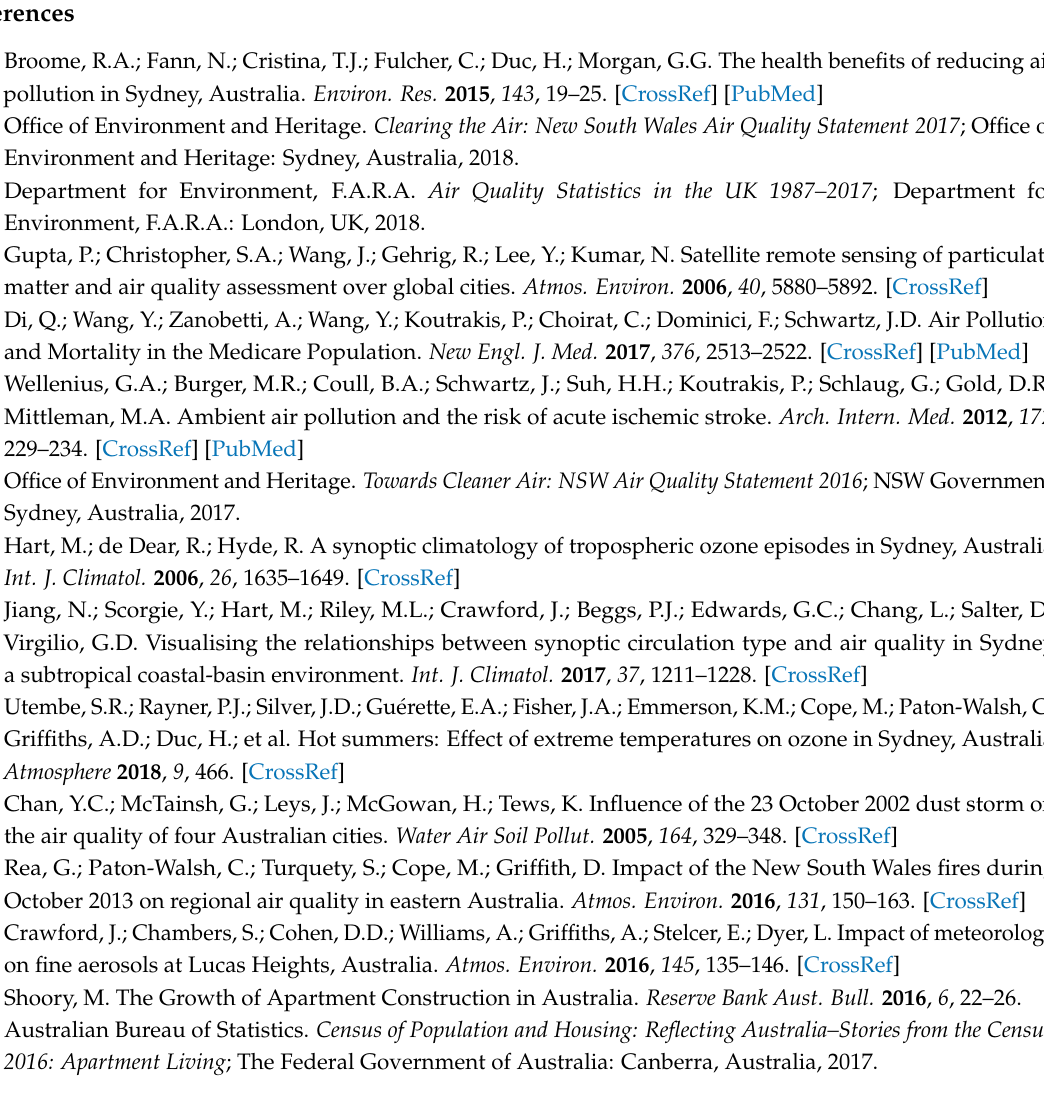
Figure A3. Hourly ( A ) and monthly ( B ) mean PM 10 concentration at the Auburn balcony site and three surrounding air quality monitoring station sites; 95% confidence intervals in the mean are shaded.